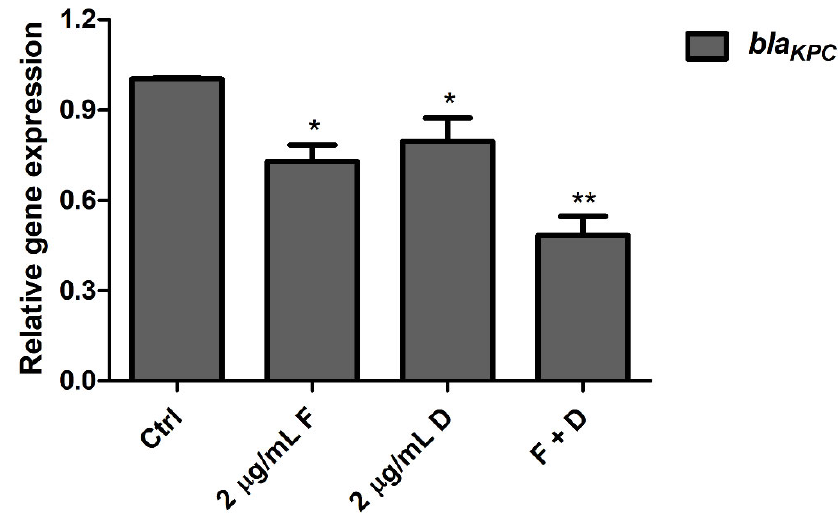
Figure 4. Transcriptional changes involving the bla KPC gene in CREC. After treatment with fingolimod alone (2 µ g/mL F), doripenem alone (2 µ g/mL D), or the combination of 2 µ g/mL of doripenem and 2 µ g/mL of fingolimod (F + D), qPCR analysis of the bla KPC gene in E. coli KBN12P05816 was performed. 16S rRNA was used to normalize the transcriptional levels of the target gene. The error bars represent the means and standard deviation (SDs). Asterisks (*) indicate statistically significant differences (* p < 0.05 and ** p < 0.01) from the controls.